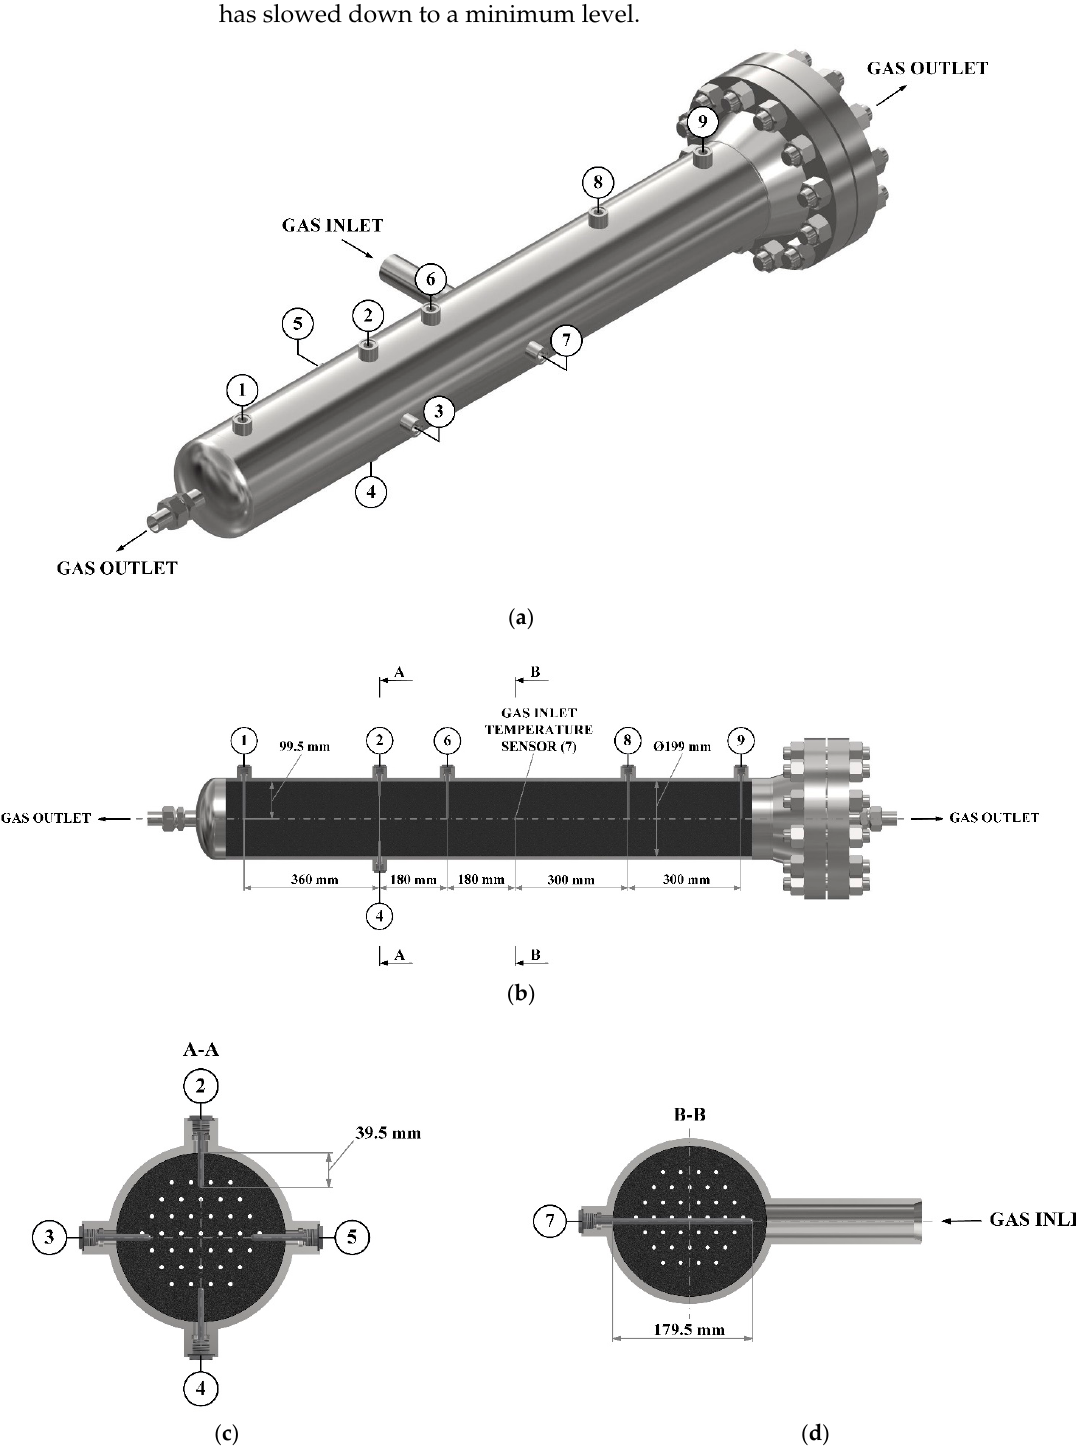
Figure 4. Scheme of temperature sensors (1–9) located inside the adsorption tank ( a ) and coordinates of the temperature sensors location ( b – d ).